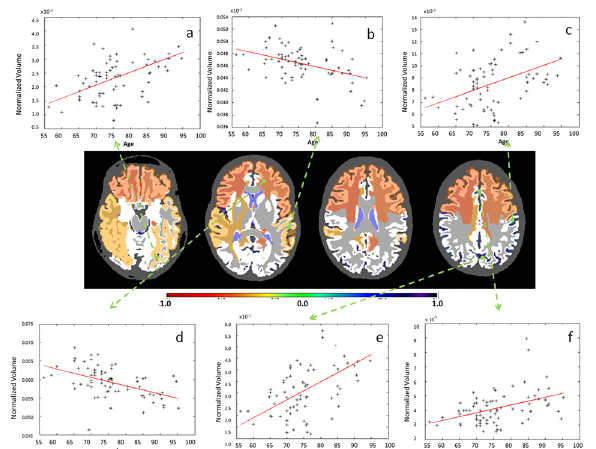
Fig 7. Examples of significant correlations between regional volumes and age at granularity level 3. The colors code the correlation coefficient R in regions where the age vs. volume curve achieves significance (p-value < 0.05, Bonferroni-corrected). Yellow / orange / red (R < 0) are regions that shrink over time, while blue (R > 0) are regions that expand over time, such as ventricles. As is shown in the figure: a. sulci of the temporal lobe (left); b. temporal lobe (left); c. sulci of the parietal lobe (left); d. anterior part of the white matter (left); e. sulci of the occipital lobe (left); f. sulci of the cingulate gyrus (left).